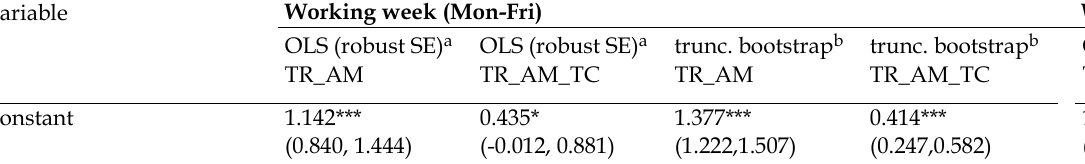
Table 4. Regression results on bias-corrected efficiency